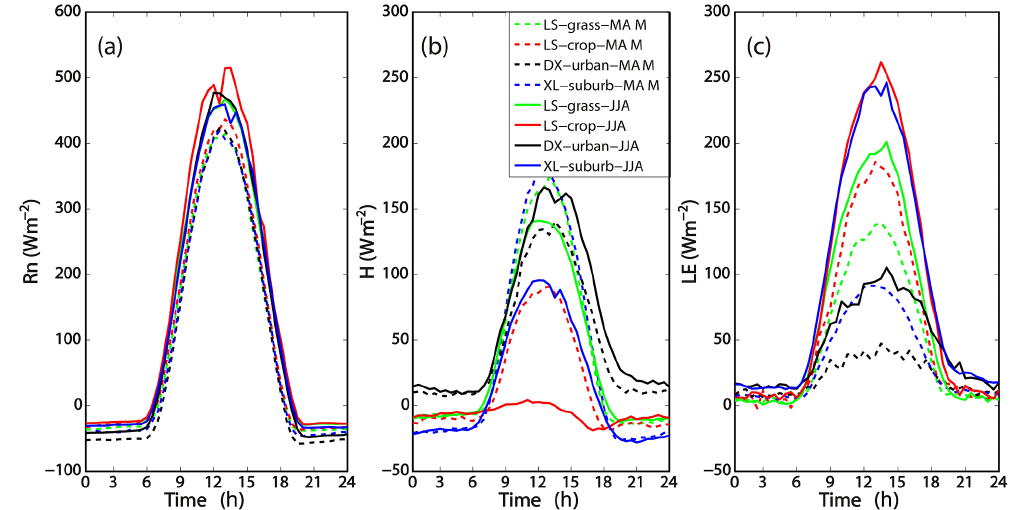
Figure 10. Diurnal variation in (a) net radiation, (b) sensible heat flux, and (c) latent heat flux at the four sites in Nanjing from March to August 2013.